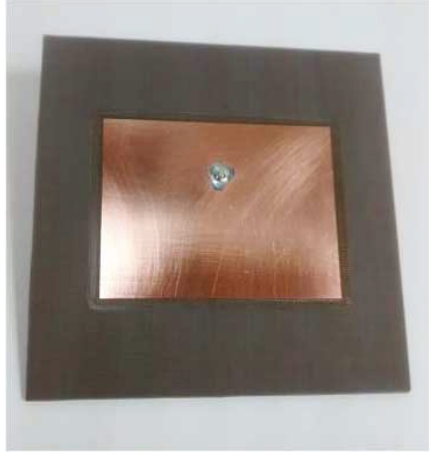
Figure 22: Conventional microstrip antenna